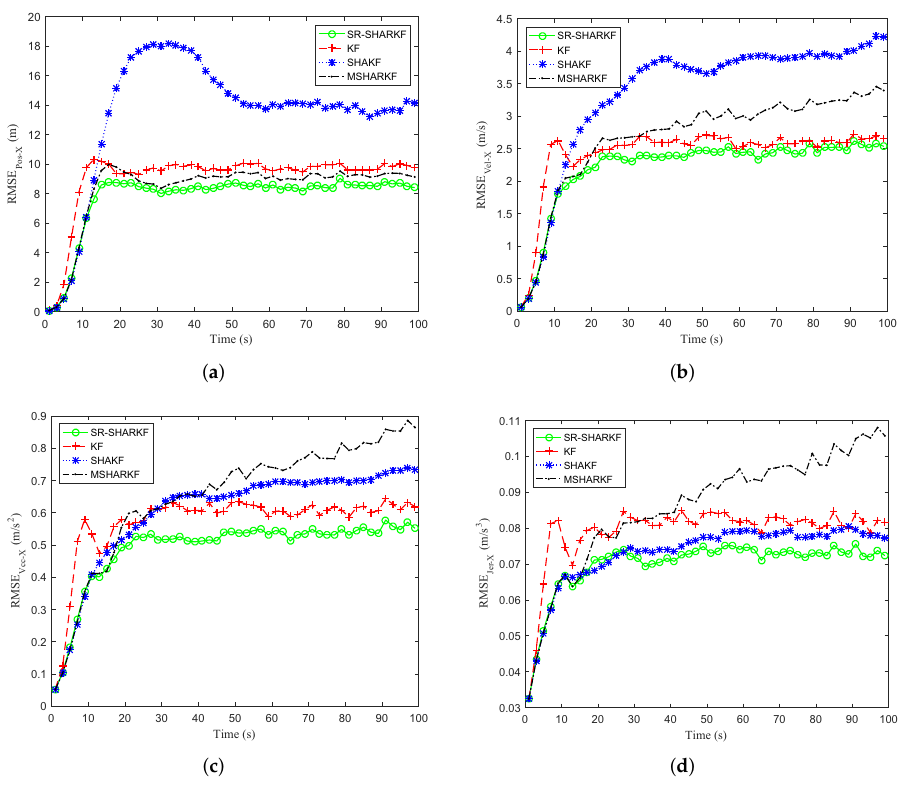
Figure 9. Dynamic parameter RMSE in the X-axis direction. ( a ) Position RMSE. ( b ) Velocity RMSE. ( c ) Acceleration RMSE. ( d ) Jerk RMSE.